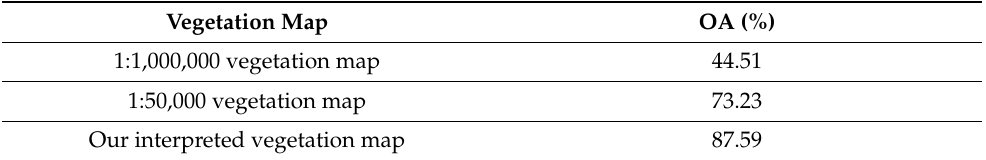
Table 4. Comparison of the accuracies achieved by different vegetation